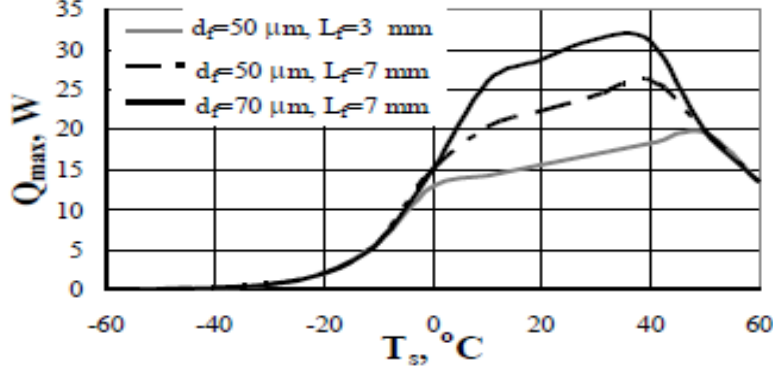
Figure 2. Choice of optimal wick parameters [30].